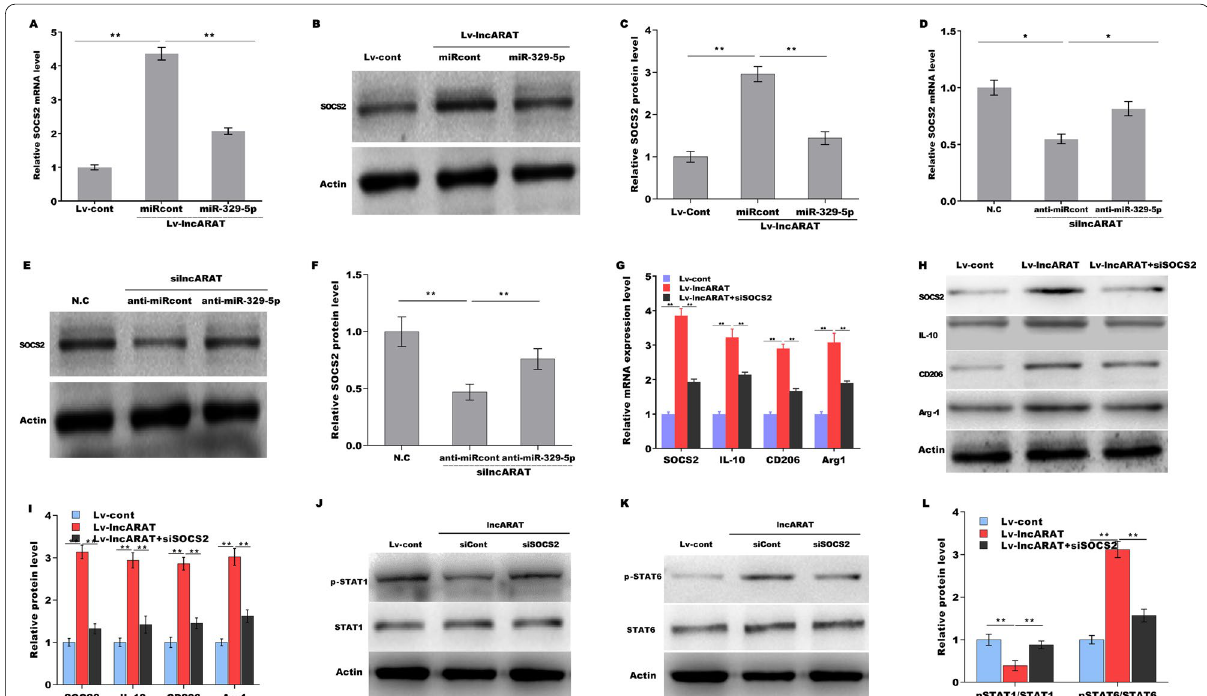
Fig. 7 The role of the lncARAT/miRNA-329-5p/SOCS2 axis in regulating macrophage function. qRT-PCR ( A ) and western blot ( B and C ) analysis of SOCS2 expression in U937 macrophages overexpressing lncARAT in the presence or absence of miRNA-329-5p. qRT-PCR ( D ) and western blot ( E and F ) analysis of SOCS2 expression in U937 macrophages treated with silncARAT in the presence or absence of miRNA-329-5p inhibitor. qRT-PCR ( G ) and western blot ( H and I ) analysis of IL-10, CD206, and Arg1 expression in U937 macrophages overexpressing lncARAT in the presence or absence of siSOCS2. J – L Western blot and quantitative analysis of p-STAT1 and p-STAT6 levels in U937 macrophages overexpressing lncARAT in the presence or absence of siSOCS2. * p < 0.05. ** p <